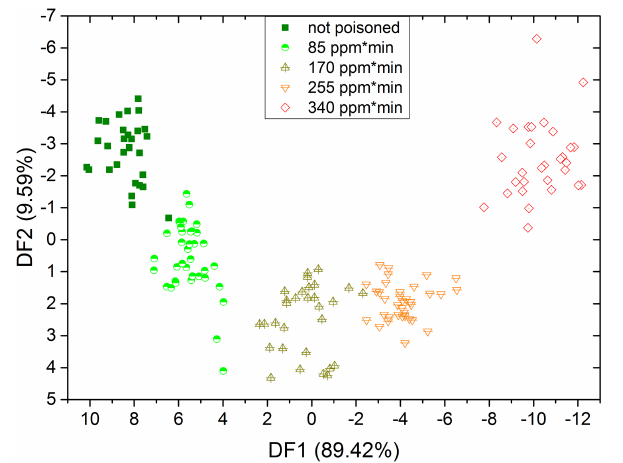
Figure 4. LDA plot showing the discrimination of different poison- ing states in pure air, both at 40%RH as well as 60%RH. The 24 features used for this LDA are based on non-normalized conduc- tance